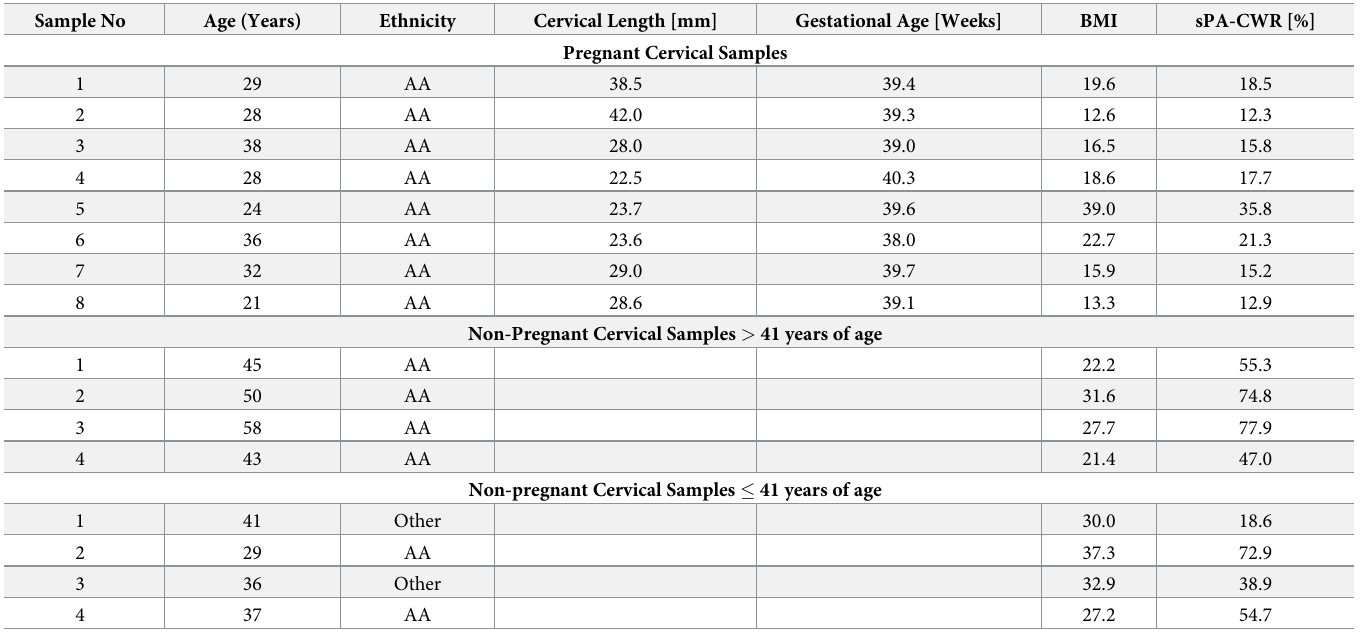
Table 1. Patient information and collagen-to-water ratio (CWR) [%] estimated by spectroscopic photoacoustic (sPA) imaging. Sample